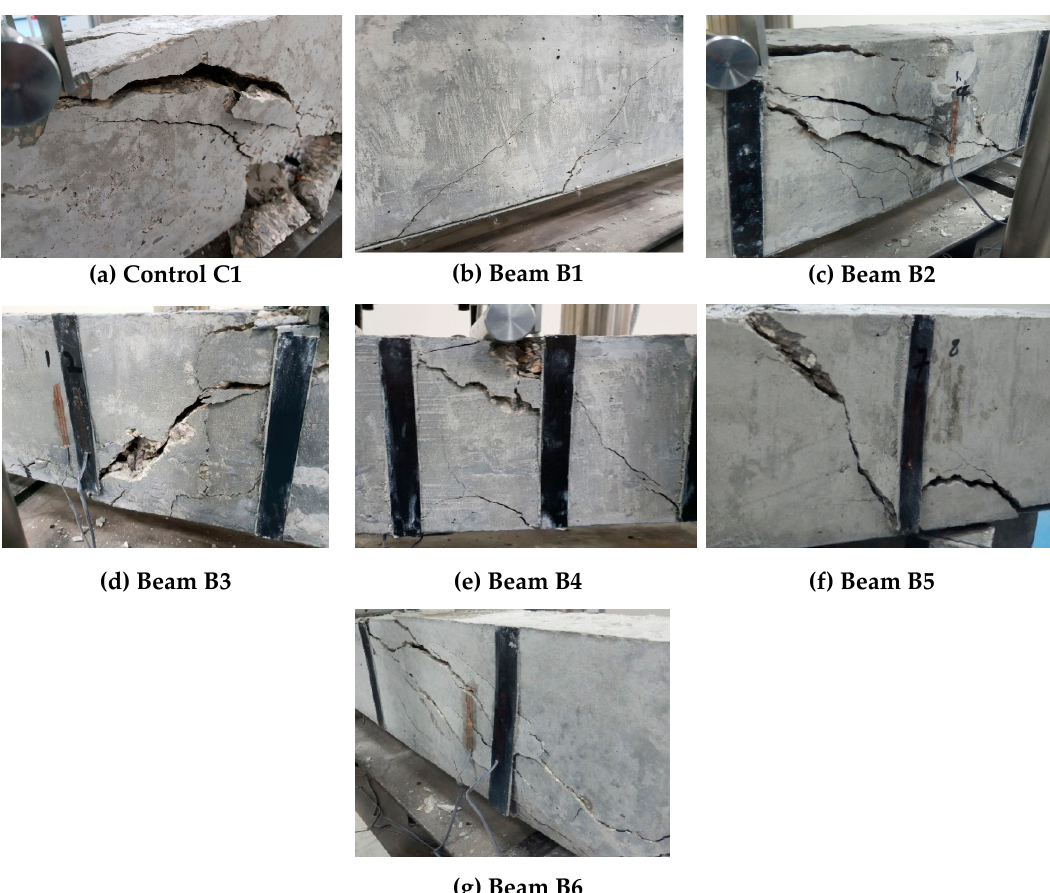
Figure 12. Detailed cracking pattern of the beams under flexural tests: ( a ) Control C1, ( b ) B1, ( c ) B2, ( d ) B3, ( e ) B4, ( f ) B5 and ( g ) B6.